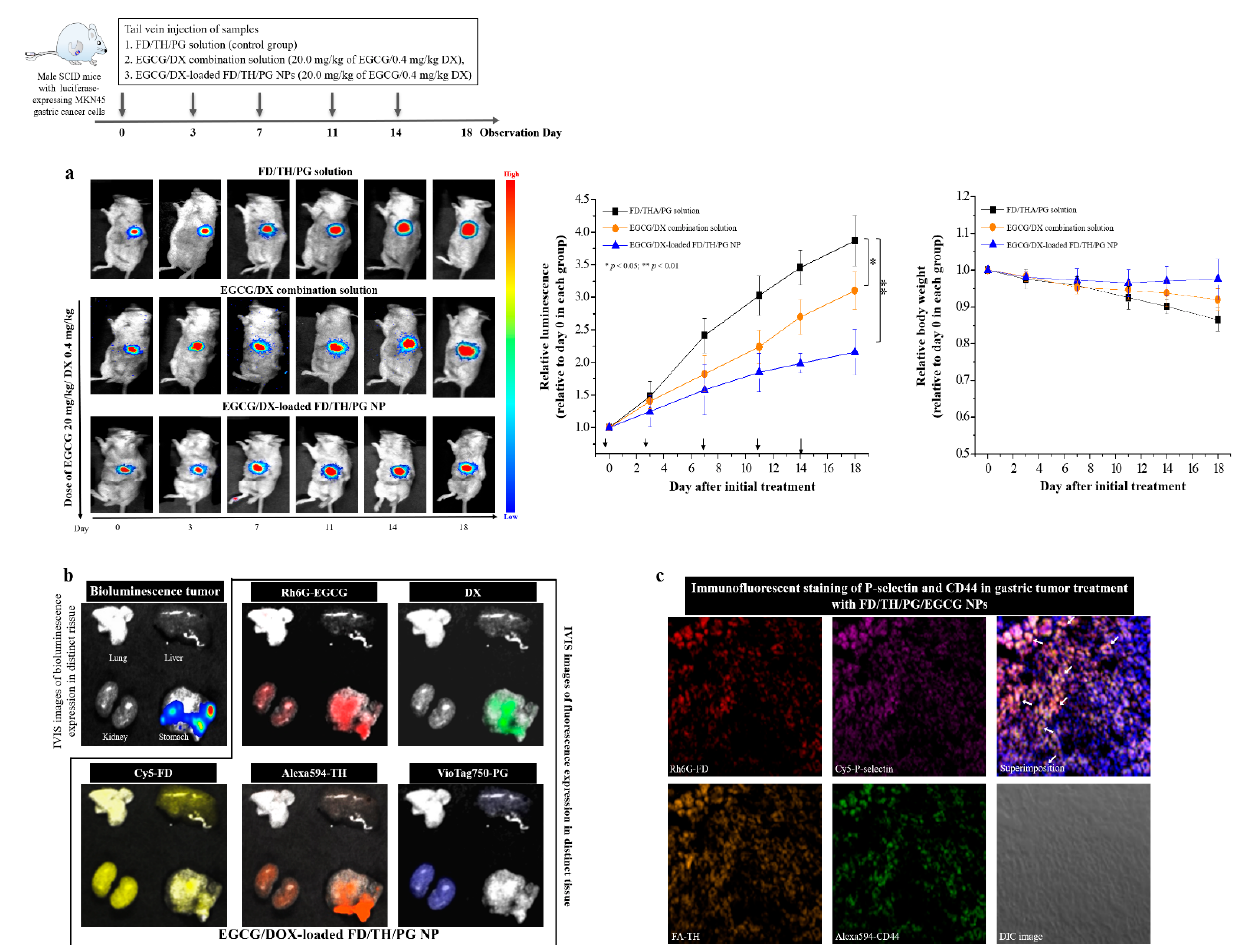
Figure 7. ( a ) The antitumor effects of different samples in orthotopic Luc MKN45 xenograft mice model. Mice were divided into three groups of six mice each and treated with FD/TH/PG solution ( ■ ), EGCG/DX combination solution ( ● ), or EGCG/DX-loaded FD/TH/PG NPs ( ▲ ). *Statistically significant difference of p < 0.05 and ** p < 0.01. ( b ) Distributions of